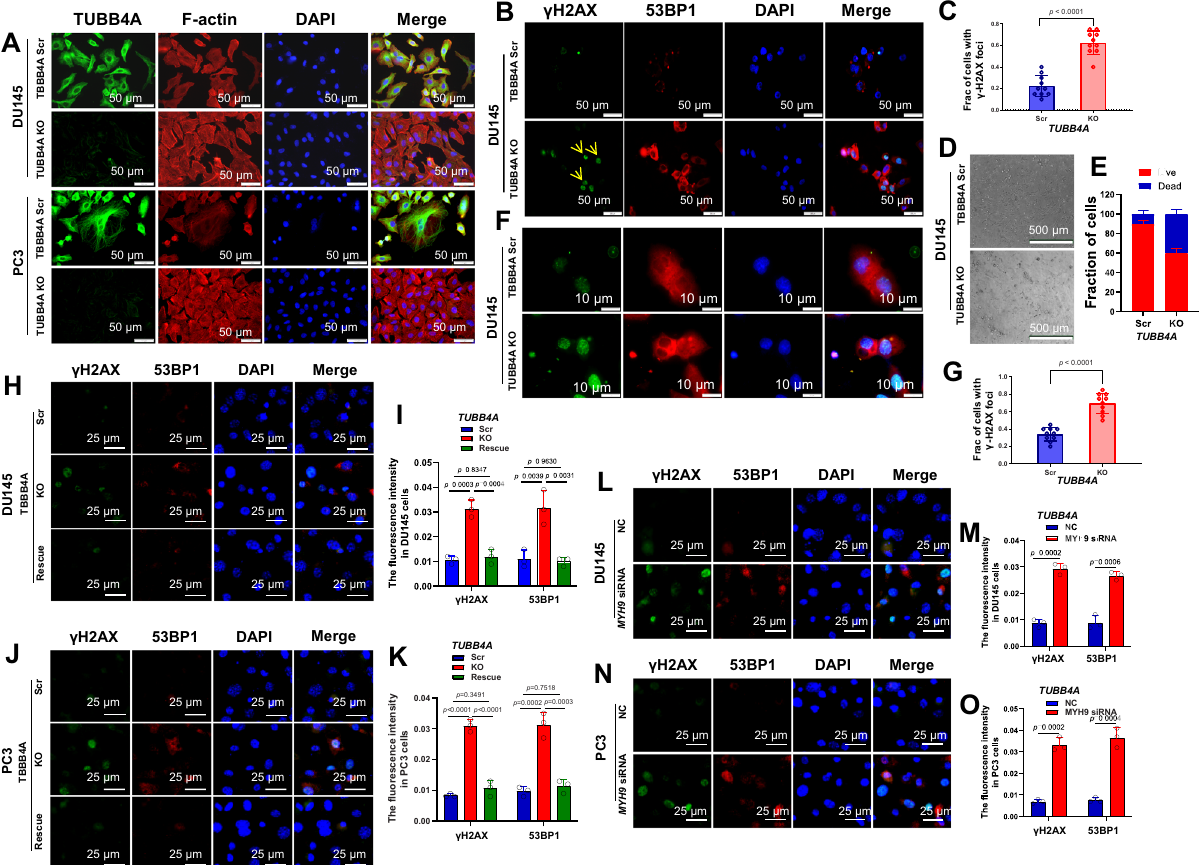
Fig. 3 TUBB4A KO and MYH9 KD increase DNA damage and cell death during migration of prostate cancer cells. A Immuno fl uorescence (IF) staining of TUBB4A and F-actin in DU145 and PC3 cells with or without TUBB4A . Scale bar, 50 μ m. B , C IF staining of γ H2AX and 53BP1 in DU145 cells with or without TUBB4A during migration in 3D extracellular matrix. Yellow arrows indicate cells with DNA damage. Scale bar, 50 μ m. D , E Death rate of DU145 cells with or without TUBB4A after migration in 3D collagen gels. Scale bar, 500 μ m. F , G IF staining of γ H2AX and 53BP1 in DU145 cells with or without TUBB4A after migration in 3D collagen gels. Scale bar, 10 μ m. H – K IF staining of γ H2AX and 53BP1 in scrambled, TUBB4A KO, and rescued DU145 and PC3 cells during migration in a 3D extracellular matrix. Scale bar, 25 μ m. L – O IF staining of γ H2AX and 53BP1 in scramble control and MYH9 KD DU145 and PC3 cells during migration in a 3D extracellular matrix. Scale bar, 25 μ m. Data are replicated 3 ( I , K , M , O ) and 10 ( C , G ) times. Data are presented as the means and SD with a two-tailed t test ( C , G , M , O ) or an ANOVA followed by Tukey ’ s post hoc t test ( I – K ). Source data are provided as a Source data fi le. Scr, scramble; KO, knockout; NC, negative control siRNA; siRNA, small interfering RNA; KD, knockdown; NS, no signi fi cant